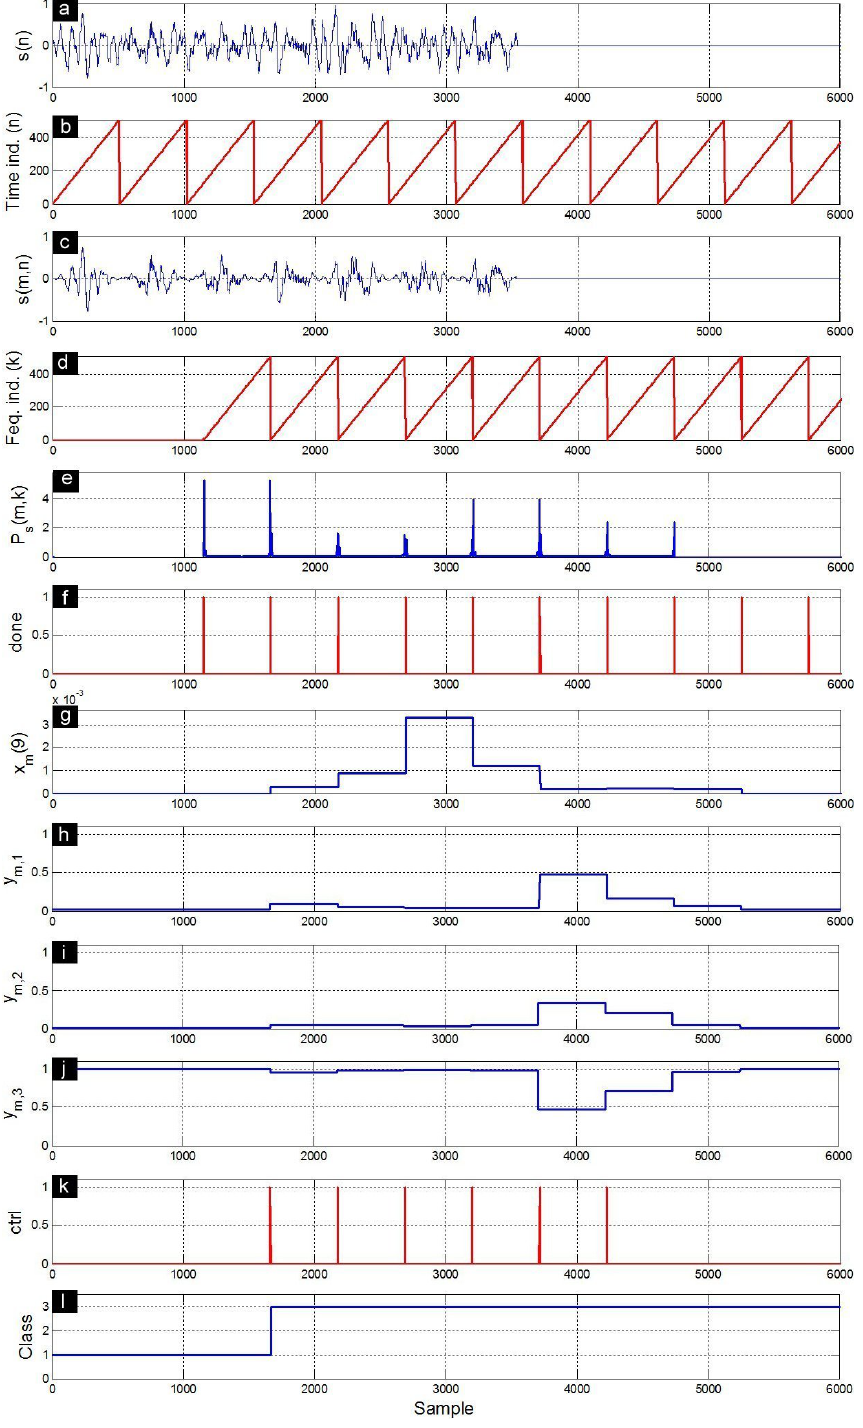
Figure 11. Response signals obtained during the characterization/classification of a D call. ( a ) input signal s ( n ) ; ( b ) time index n that allows to delimit successive frames s ( m , n ) ; ( c ) windowed signal s ( m , n ) ; ( d ) frequency index k that allows to delimit successive power spectra; ( e ) power spectra P s ( m , k ) ; ( f ) done signal; ( g ) ninth component of the feature vector x m ( 9 ) ; ( h ) first MLP output y m ,1 ; ( i ) second MLP output y m ,2 ; ( j ) third MLP output y m ,3 ; ( k ) ctrl signal; and ( l ) recognized